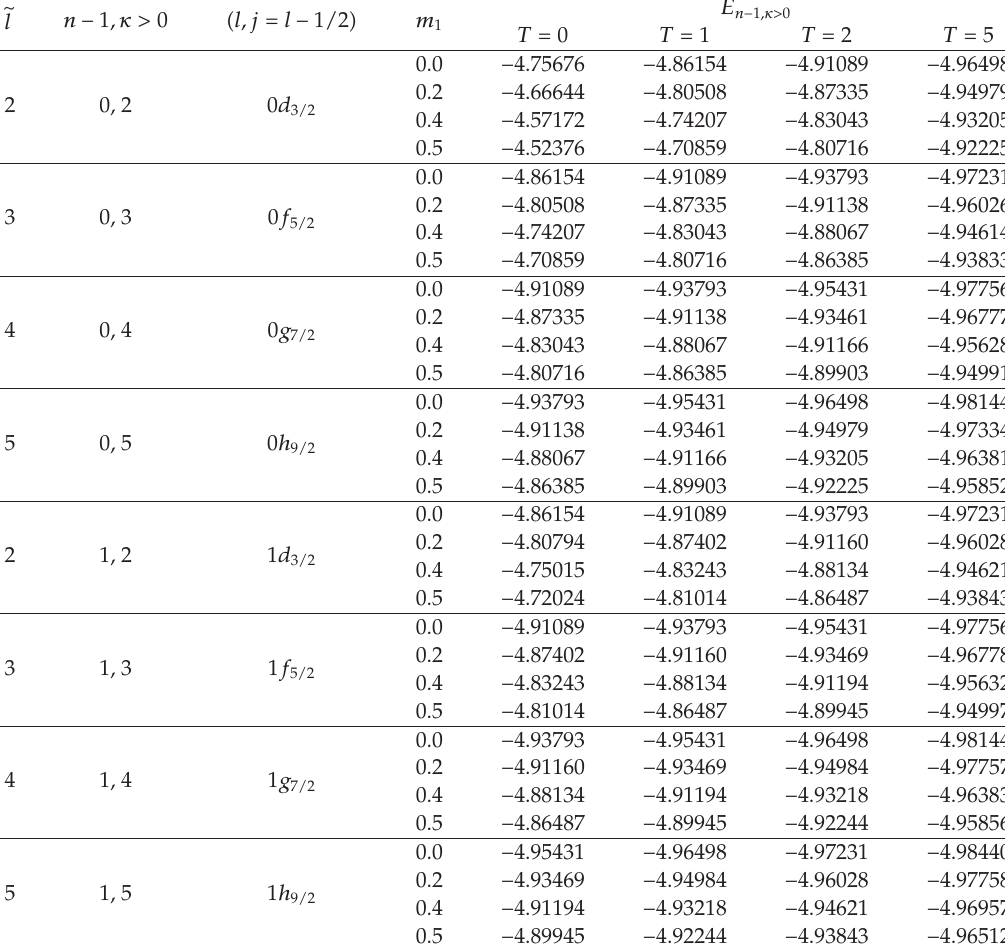
Table 2: The bound state energy eigenvalues of the Coulomb potential under the pseudo-spin symmetry limit for several values of n and κ for m 0 (cid:5) 5 . 0fm − 1 , q (cid:5) 1 , (cid:2) (cid:5) c (cid:5) 1 , T (cid:5) (cid:2) 0 , 1 , 2 , 5 (cid:3) , and C ps (cid:5) −